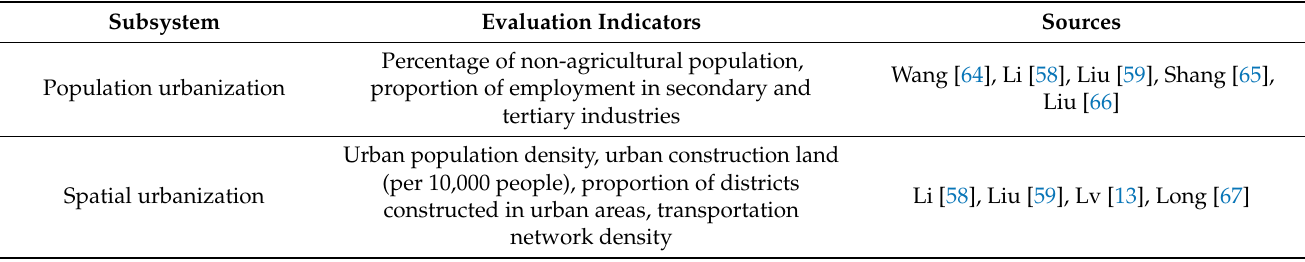
Table 1. Previous study of evaluation index system for urbanization.